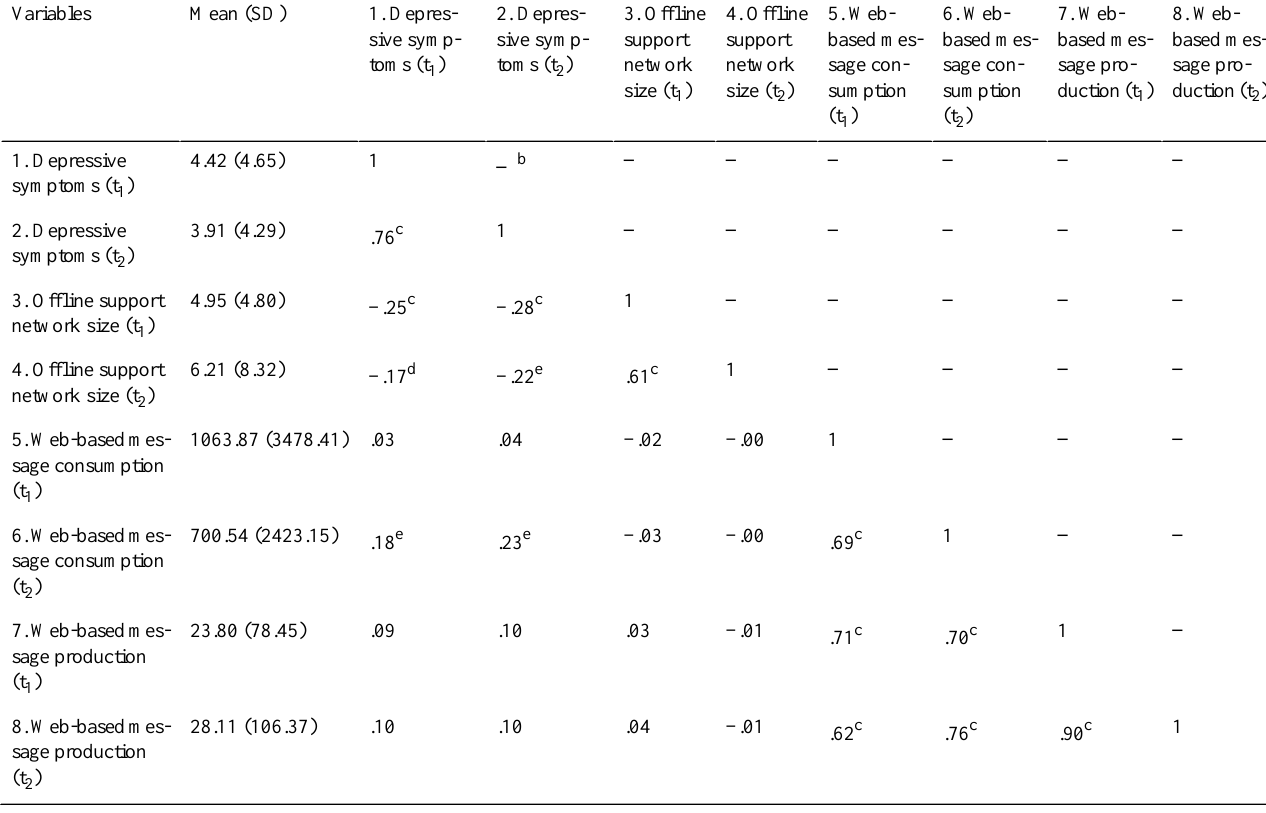
Table 2. Means, SDs, and Pearson correlation coefficients for key variables at both